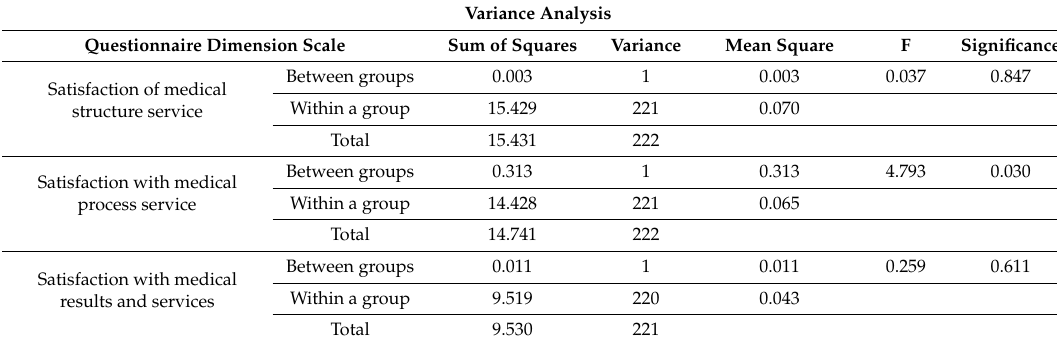
Table 21. Variance analysis.